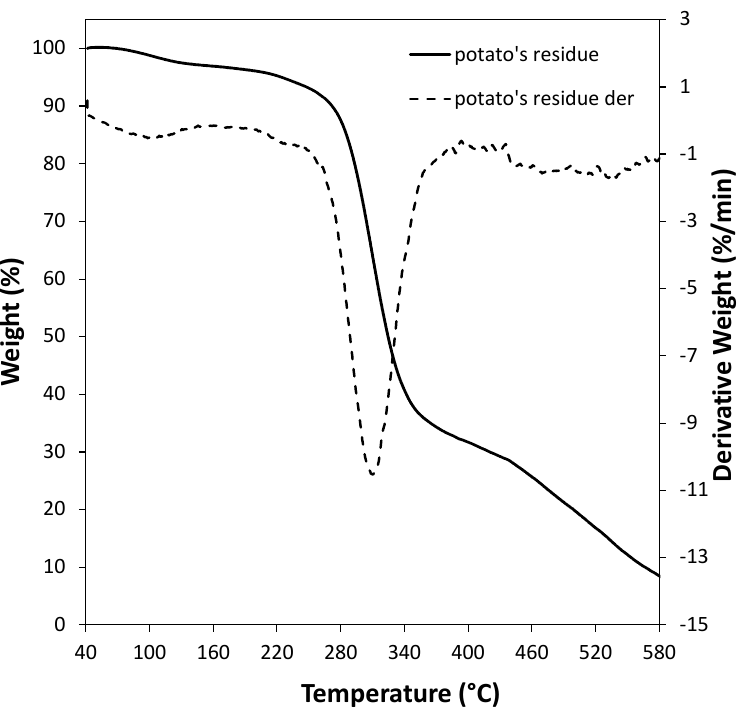
Figure 5. Thermogravimetric analysis (TGA) curve (solid line, left axis) and related derivative curve (dotted line, right axis) of sweet potato residue.